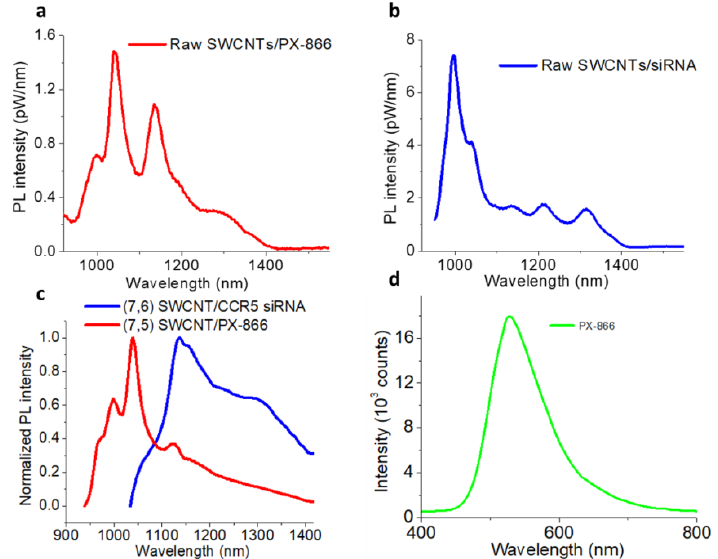
Figure 4. Emission spectra of raw CoMoCAT SWCNTs dispersed with ( a ) PX-866, ( b ) siRNA. Emission spectra of ( c ) (7,5) and (7,6) sorted washed / annealed SWCNTs dispersed with PX-866 and CCR5 siRNA, respectively. ( d ) Visible emission spectrum of PX-866 with 400 nm excitation.